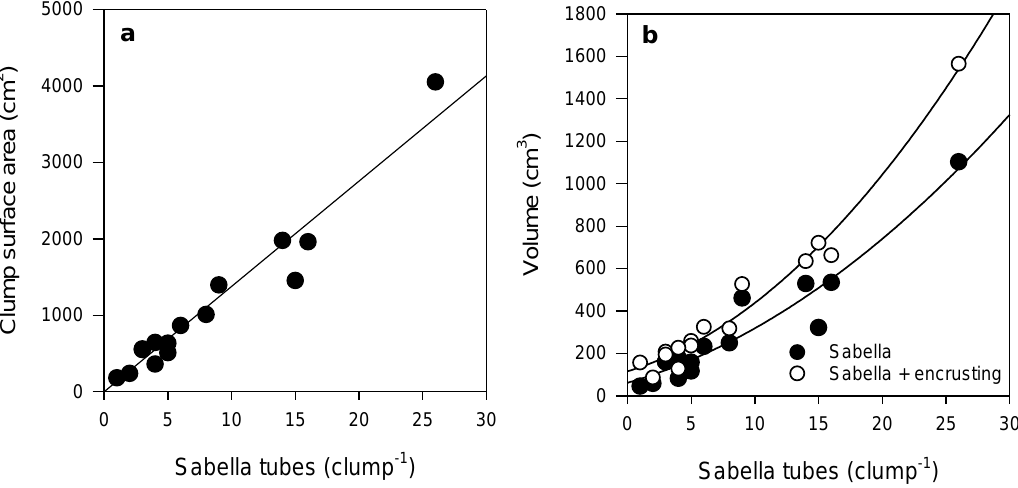
Figure 1. Relationship between ( a ) number of Sabella tubes and clump surface area (SA) (linear regression R 2 = 0.94, n = 15), and ( b ) volume of Sabella and the total volume of Sabella (polynomial regression R 2 = 0.92, n = 15) and encrusting epifauna (polynomial regression R 2 = 0.98, n = 15) in each clump. See Table S2 for further curve fit detail.